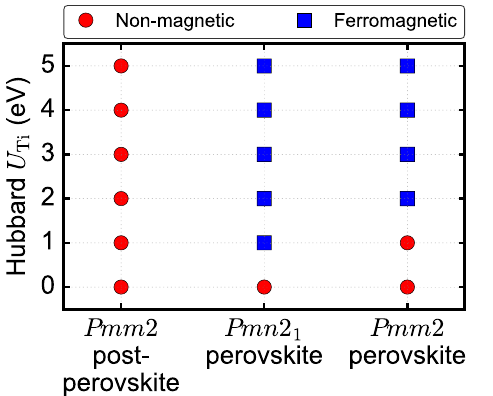
Fig. 3 Phase diagram as a function of Hubbard U . The magnetic phase diagram of the post-perovskite Pmm 2, perovskite Pmn 2 1 and perovskite Pmm 2 structures as a function of Hubbard U . Non-magnetic state and Ti ferromagnetic state are shown by red circle and blue square, respectively.